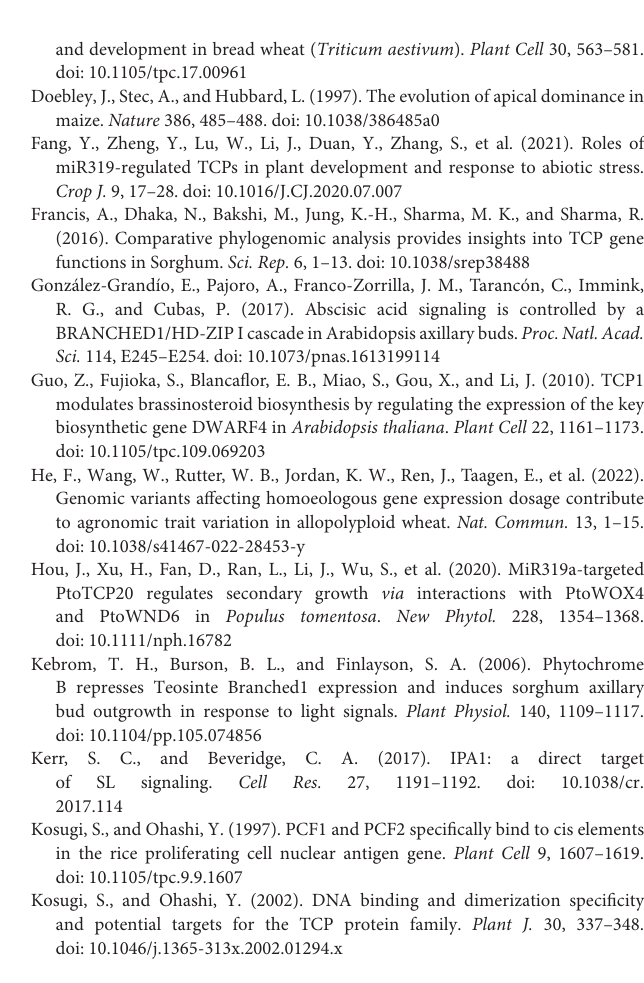
Supplementary Table S2 | List of primer sequences used in this study. Supplementary Table S3 | The detailed information of putative TCP members in Ma bamboo. Supplementary Table S4 | The detailed information of conserved motifs in DlTCPs. Supplementary Table S5 | Putative microRNA319-targeted binding sites of DlTCPs. Supplementary Table S6 | The detailed information and Ka/Ks ratio of putative orthologous and paralogous pairs. Supplementary Table S7 | The detailed information of three kinds of differentially expressed